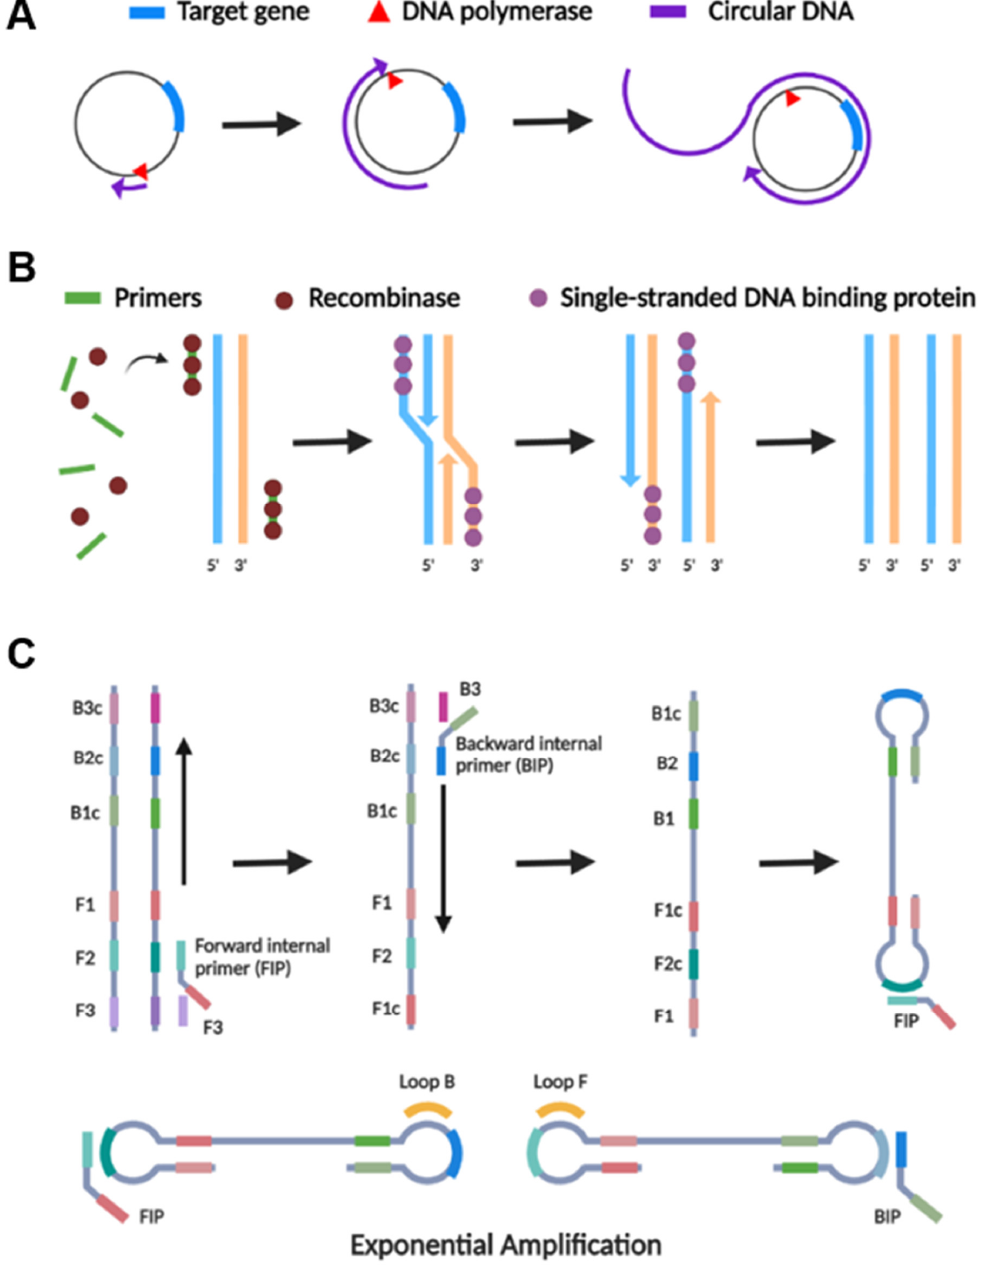
Figure 3. The basic schematic principles of isothermal amplification methods. ( A ) The principle of rolling circle amplification (RCA). ( B ) The principle of recombinase polymerase amplification (RPA). ( C ) The principle of loop-mediated isothermal amplification (LAMP). Created with BioRen- der.com.